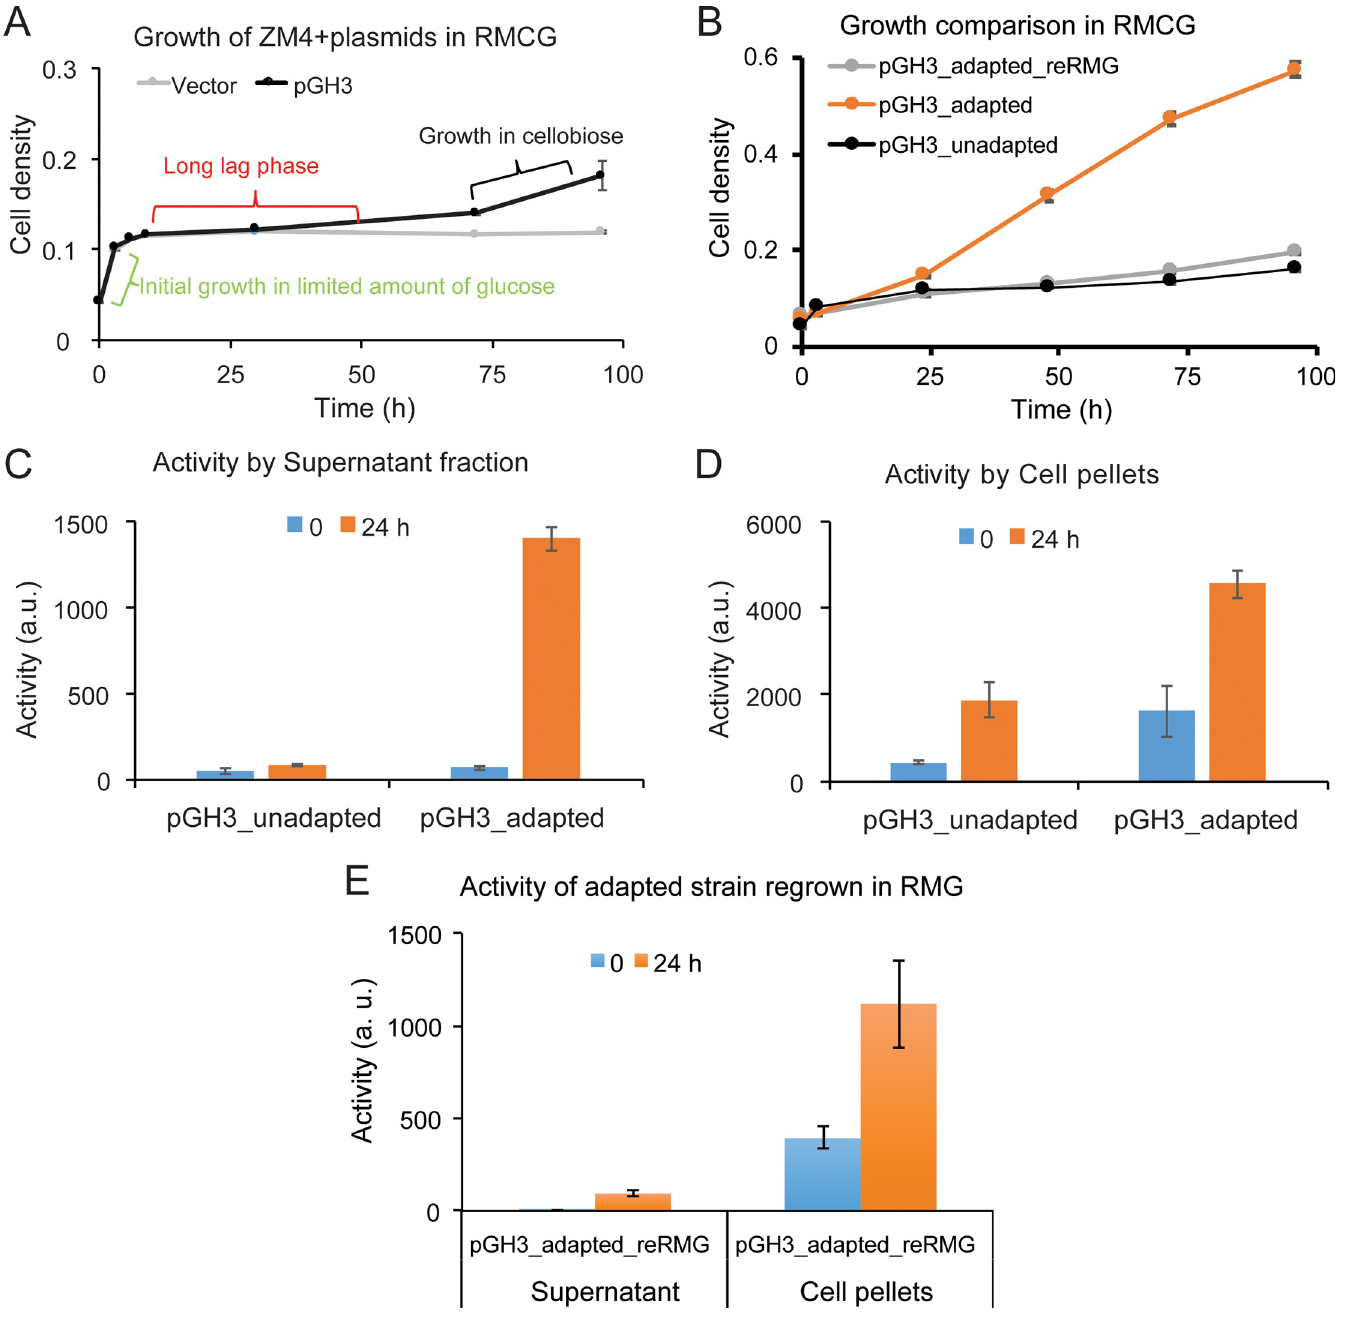
Fig 2. Growth and physiological changes induced by adaptation to cellobiose medium. (A) Growth of Z . mobilis ZM4 transformed with control pVector or pGH3 in 2% cellobiose medium with 0.05% glucose (RMCG). Z . mobilis GH3 growth in RMCG can be described in three stages: initial growth on glucose, a long lag phase, and growth on cellobiose. (B) Growth comparison of Z . mobilis GH3 in RMCG. Cells were either adapted to cellobiose, unadapted to cellobiose, or adapted to cellobiose and then regrown in RMG (reRMG). Extracellular (C) and whole-cell (D) GH activity for RMCG-adapted or -unadapted Z . mobilis GH3. (E) Extracellular and whole cell GH activity of RMCG-adapted Z . mobilis GH3 grown in RMG after adaptation before returning to RMCG. GH activity reported as relative fluorescence signal produced per min normalized by input cell number (apparent OD 600 ). Error bars are standard deviations of biological triplicates.